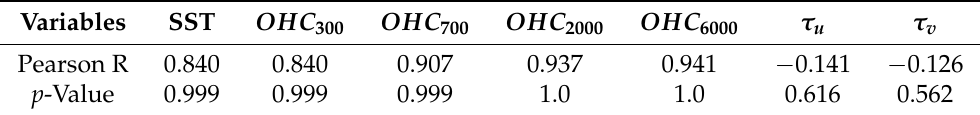
Table 2. The correlation coefficient between AMOC leading mode and leading modes for the other